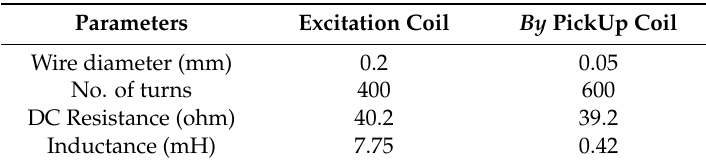
Figure 1. The rectangular excitation coil (REC) and orthogonal By pickup coil. Table 1. Parameters of the excitation coil and By pickup coil.